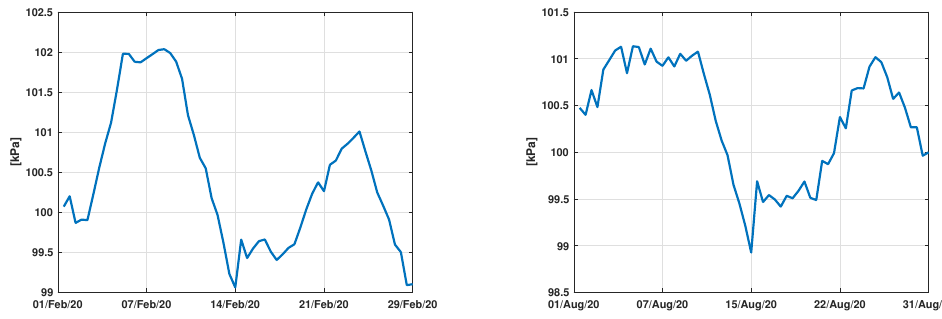
Figure 15. Site 1—Atmospheric pressure averaged values: February 2020 ( left ) and August 2020 ( right